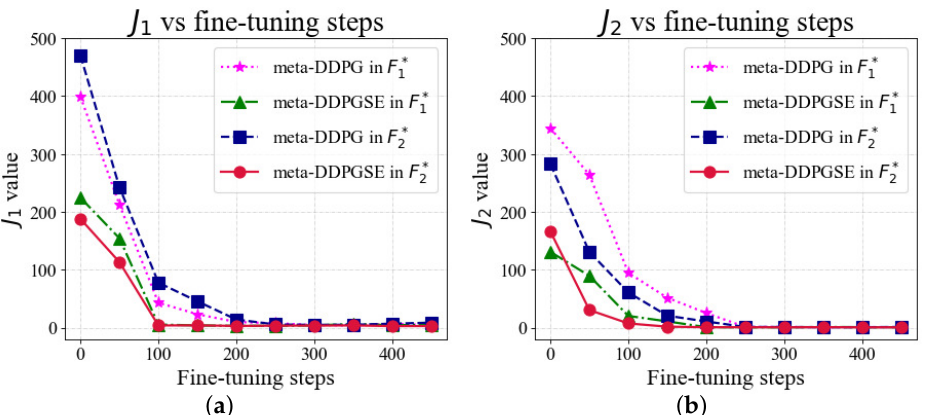
Figure 10. Effect of number of fine-tuning steps on J 1 and J 2 in the straight scenario: ( a ) J 1 value vs. fine-tuning steps; ( b ) J 2 value vs. fine-tuning